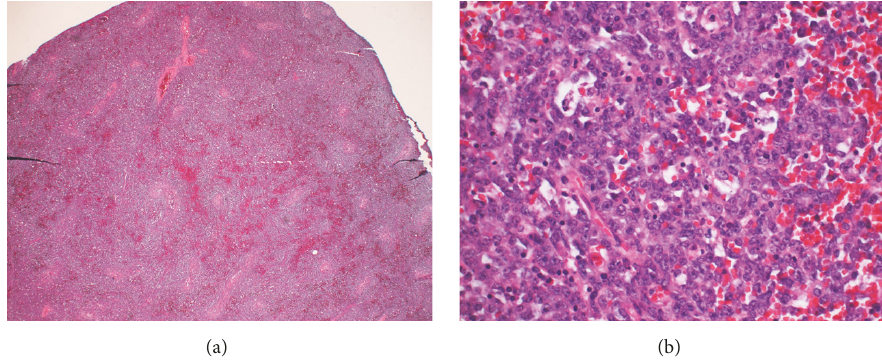
Figure 2: Section of the right testis stained with hematoxylin and eosin. (a) Low power (2x) shows diffuse infiltration of the testis by large neoplastic cells. There is geographic necrosis. (b) Higher magnification (40x) shows the large cells with irregular nuclei, vesicular chromatin, and prominent nucleoli. Occasional mitoses and apoptotic bodies present.